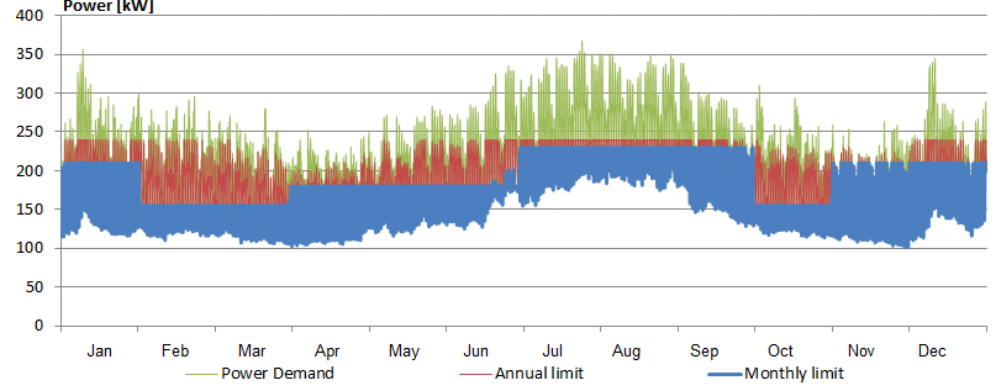
Figure 8. Demand and main grid contribution (annual and monthly